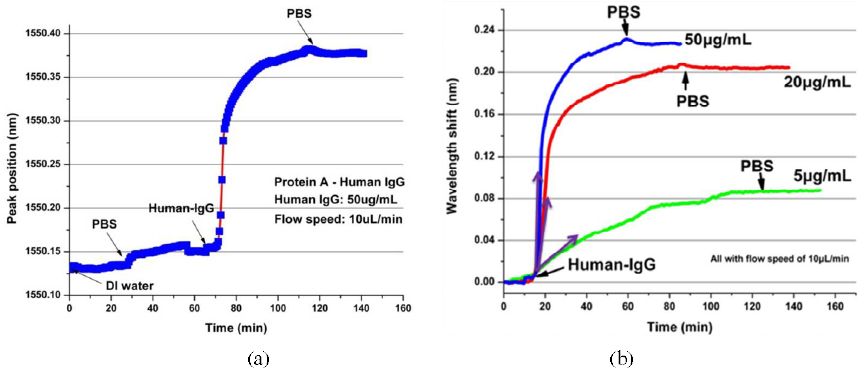
Figure 28. ( a ) The monitoring process of the polymer-based microring biosensor for the surface binding sensing and ( b ) the responsivities of the photonic biosensor with different concentrations of Human-IgG [36].